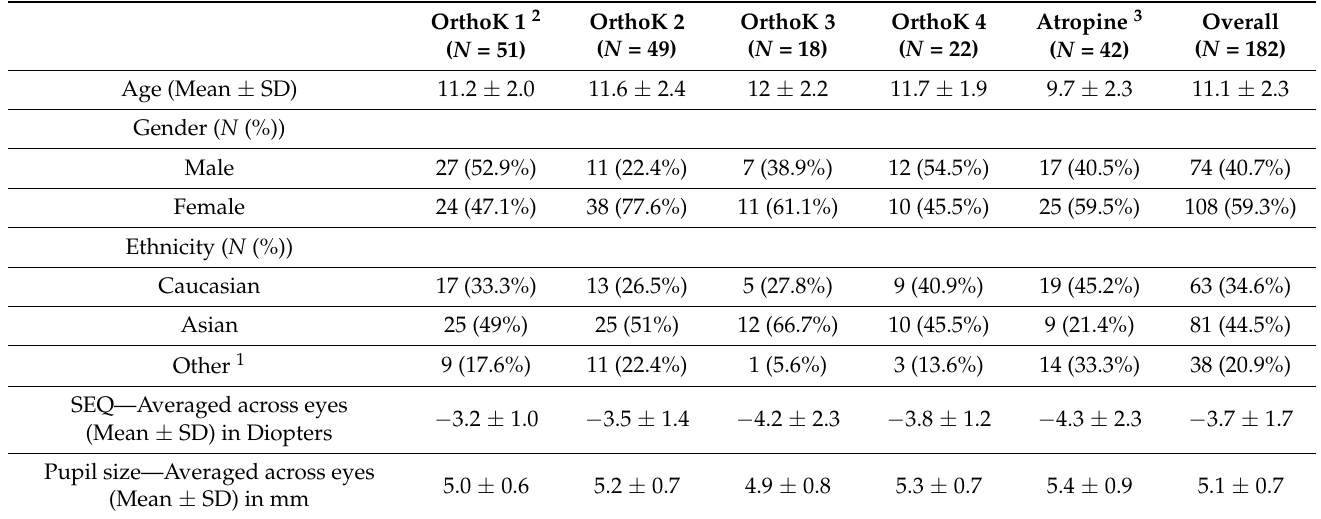
Table 4. Background statistics for the OrthoK and atropine groups at baseline.